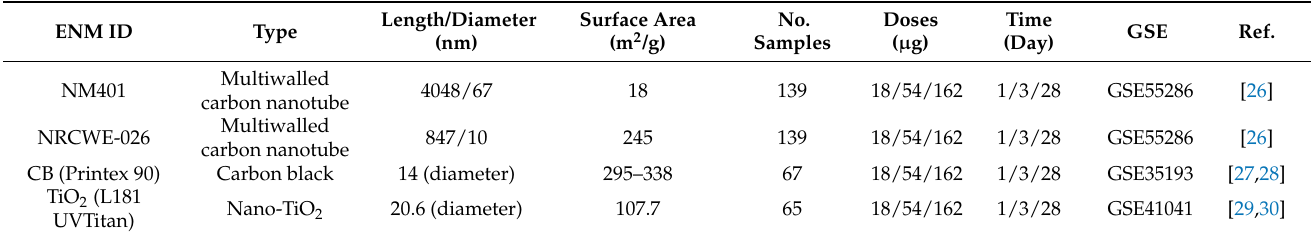
Table 1. Datasets used in this